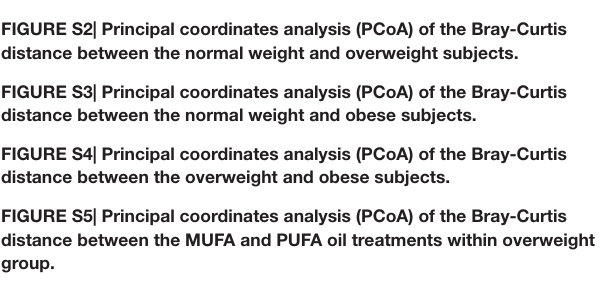
FIGURE S7| Serum lipid profiles at the endpoint of five experimental diets. Significant differences between treatments are highlighted within each parameter. TABLE S1 | List of fecal samples collected from the COMIT study. TABLE S2 | Example of a 7-day rotation isocaloric menu during the intervention. TABLE S3 | Summary of sequenced OTUs at each taxonomic level.